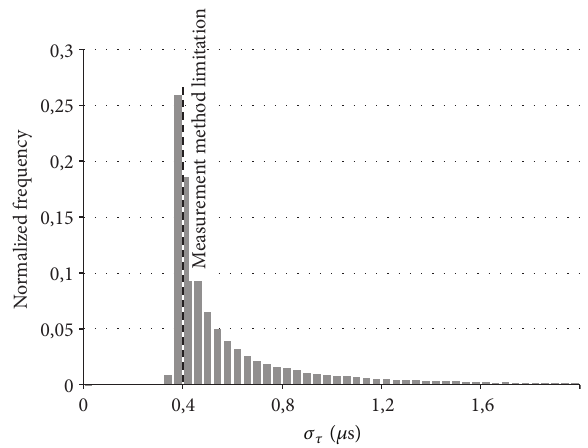
Figure 6: Histogram of rms delay spread values measured in hilly